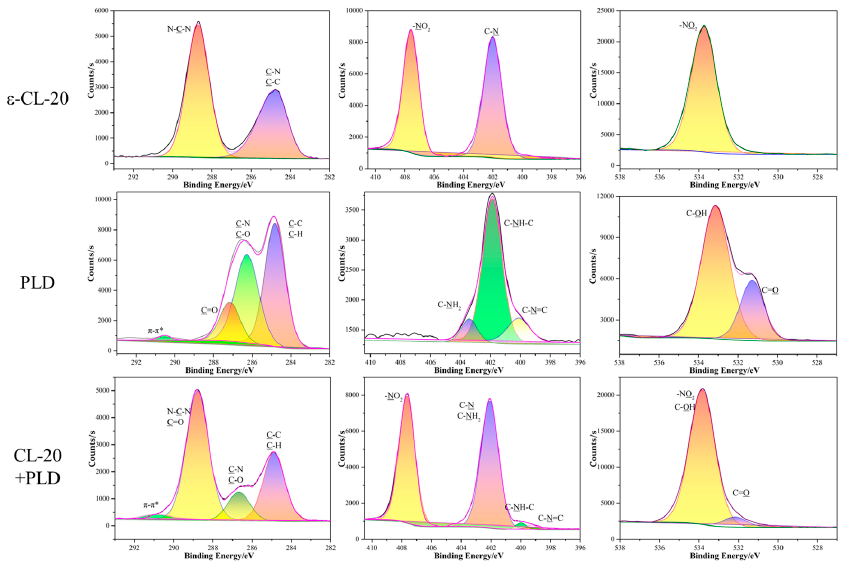
Figure 5. XPS spectra for ε‐ CL ‐ 20, PLD, and ε‐ CL ‐ 20/PLD core ‐ shell composites.